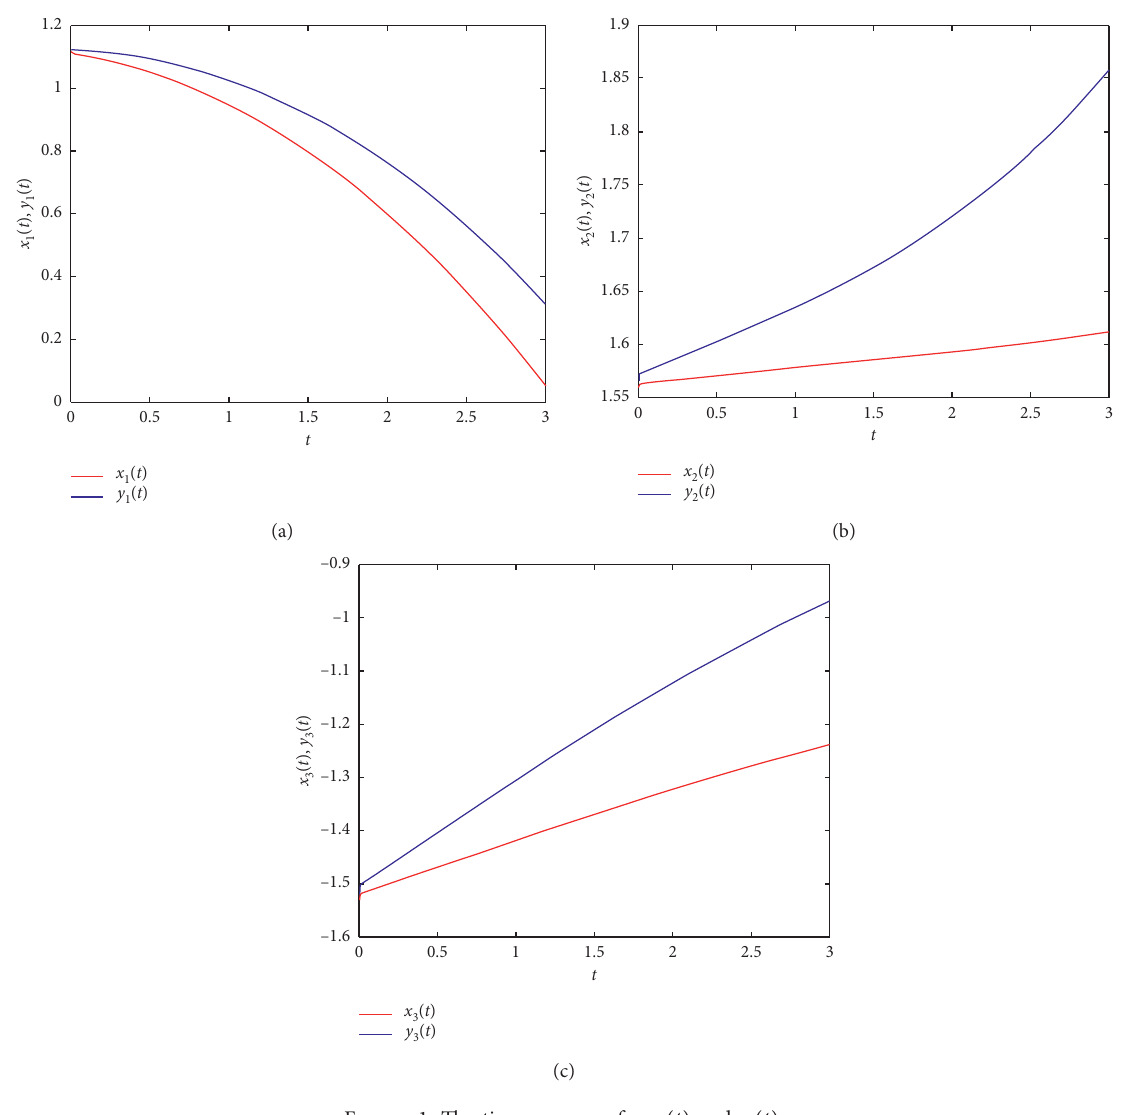
Figure 1: The time response for x ( t ) and y ( t ) .